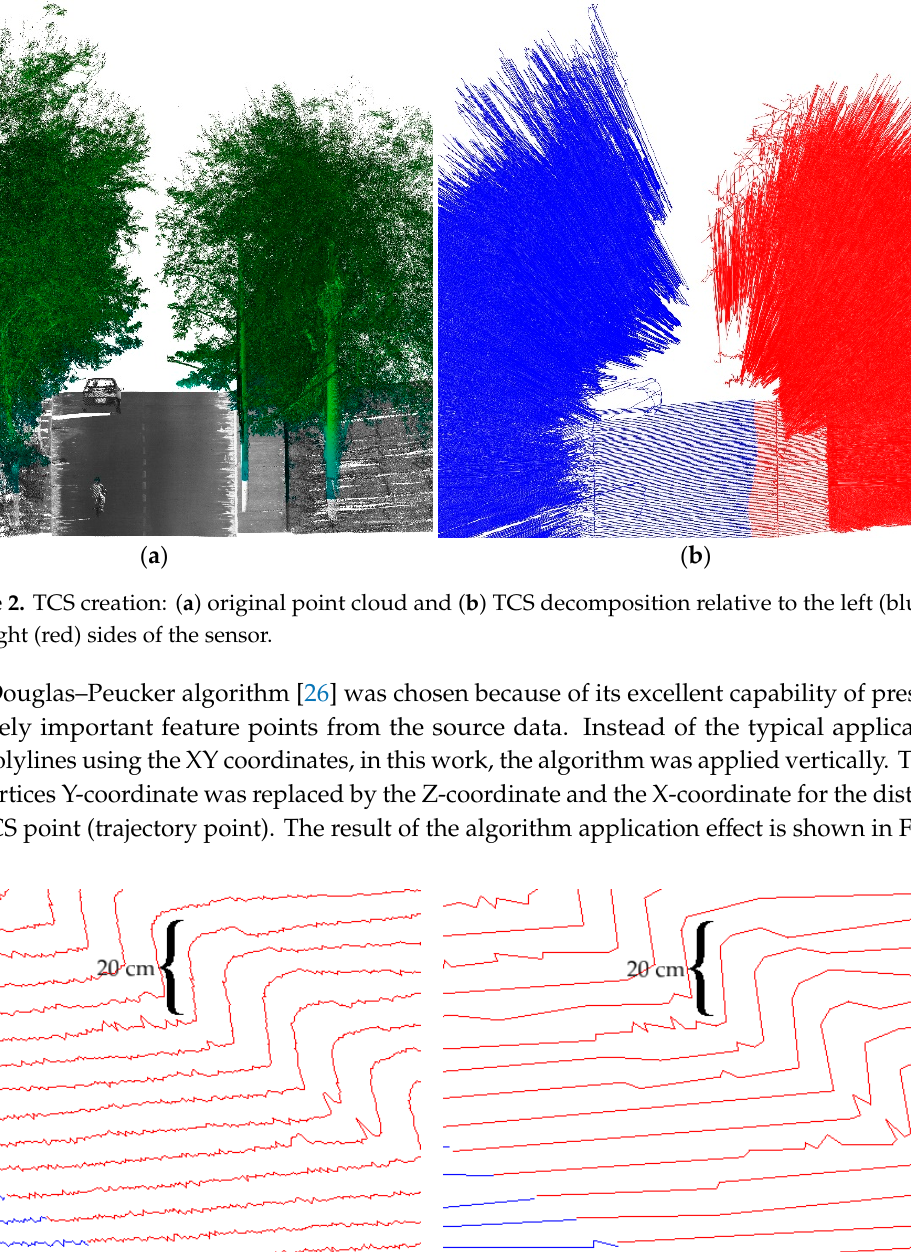
( b ) Figure 4. TCS intersection with the curb sudden terrain change effect: ( a ) isometric trajectory perspective view and ( b ) terrain top view. The greater the terrain vertical inclination, the sharper the inflection effect. Based on that, by using the trajectory distance of each point, it was possible to quantify the vertical relative variation